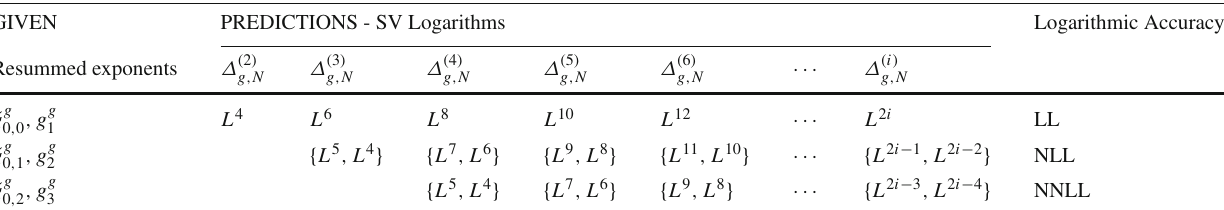
Table 1 The set of resummed exponents accuracy. Here L j = ln j N GIVEN PREDICTIONS - SV Logarithms Logarithmic Accuracy